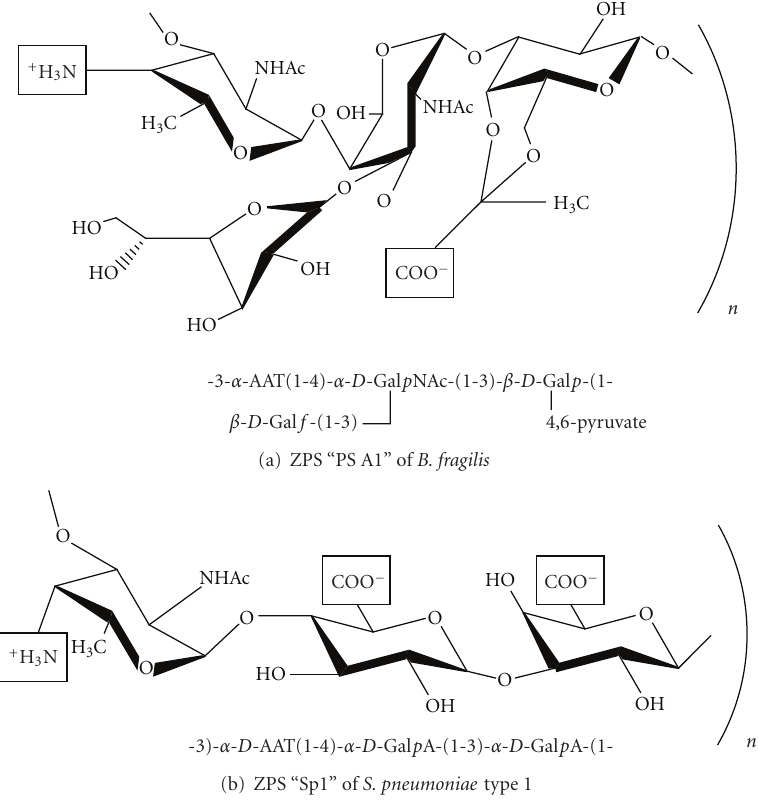
Figure 1: Structure of ZPSs. (a) Repeating sugar molecules of Bacteroides fragilis PS A1 carrying zwitterionic charge motives. (b) ZPS Sp1 of S. pneumoniae serotype